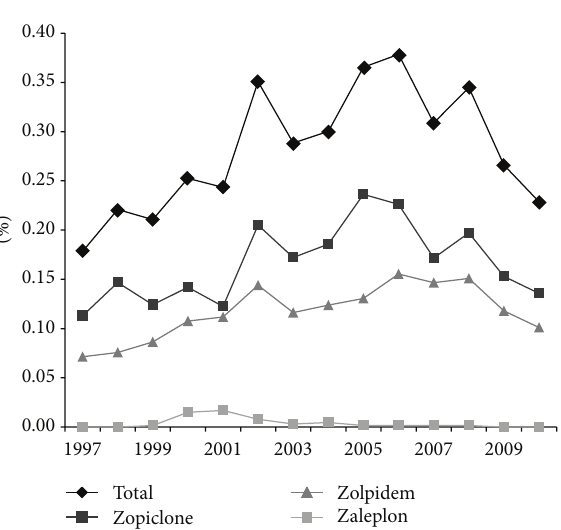
Figure 1: Exposure of hypnotic benzodiazepine receptor agonist (HBRA) among pregnant women from 1997 to 2010. Drug exposure is divided into subgroups of the different HBRAs available in Denmark.